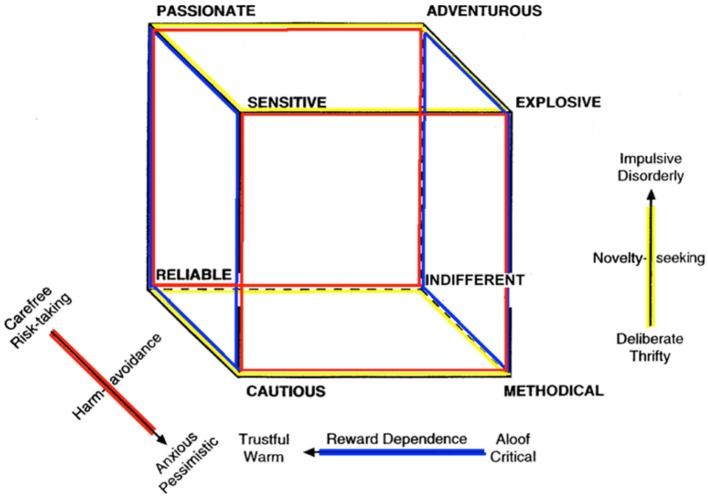
The Temperament Cube (Cloninger, 1987).